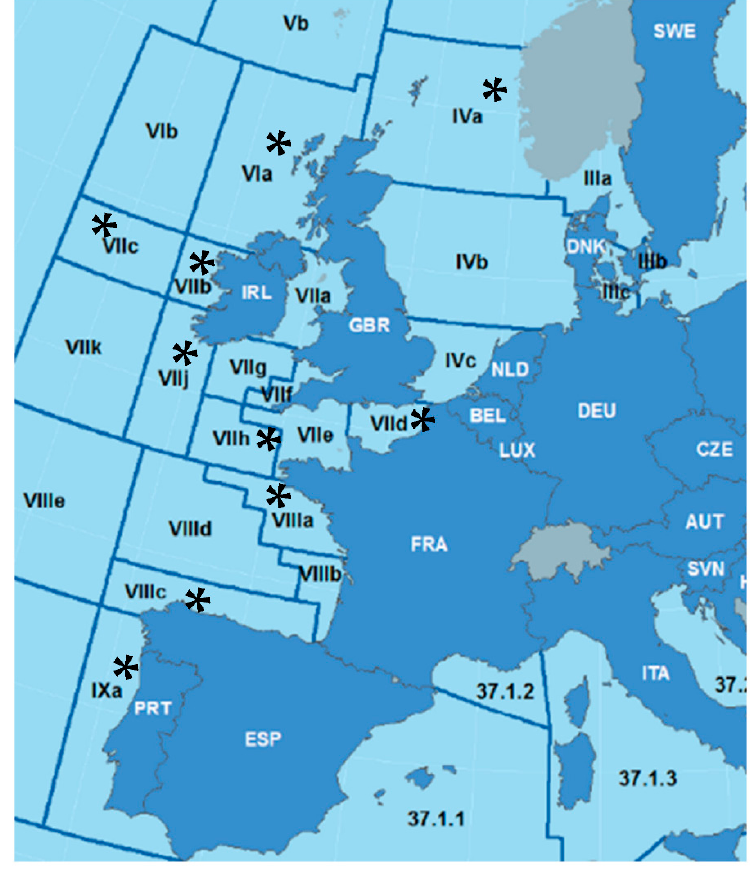
Figure 1. Sampling areas (*) according to ICES Division Areas: IVa (Northern North Sea); VIa (Northwest Coast of Scotland and North Ireland); VIIb (West of Ireland); VIIc (Porcupine Bank); VIIh (Celtic Sea/South); VIIj (Southwest of Ireland/East); VIIIa (Bay of Biscay/North); VIIIc (Bay of Biscay/South); VIIId (Bay of Biscay/ Offshore); and IXa (Portuguese Waters/East) .